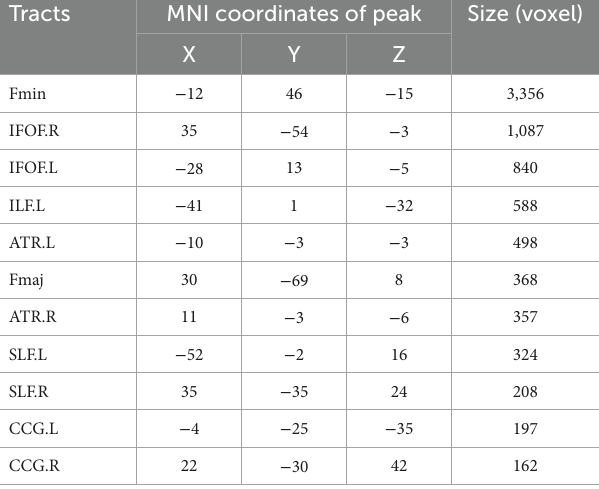
TABLE 4 The tracts that positively corelated to motion coherence threshold. Tracts MNI coordinates of